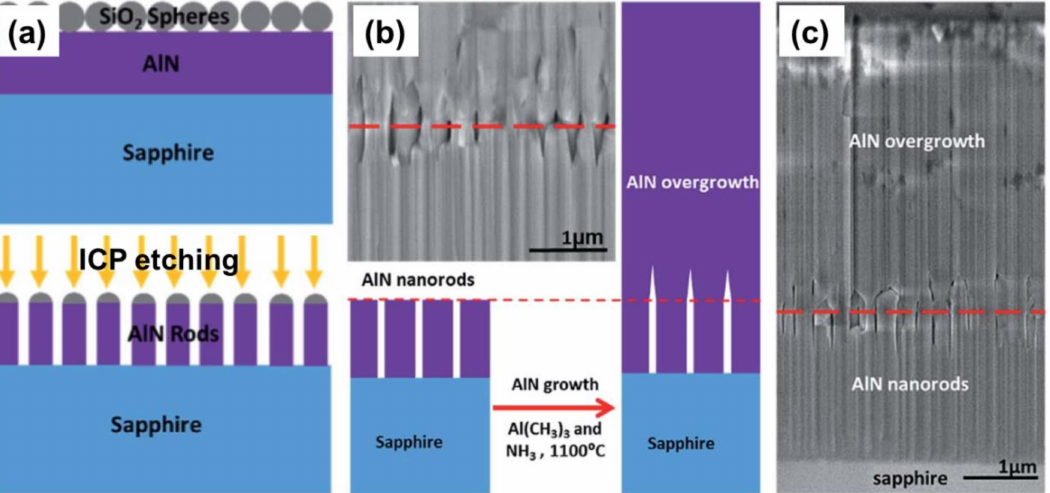
Figure 11. ( a ) Cross-sectional schematic diagram of the fabrication process for AlN nanorods; ( b ) cross-sectional SEM image of the ELOG-AlN on nanorods and the corresponding schematic dia- gram; ( c ) cross-sectional SEM image of the entire AlN/sapphire template. Reprinted from [60] with copyright